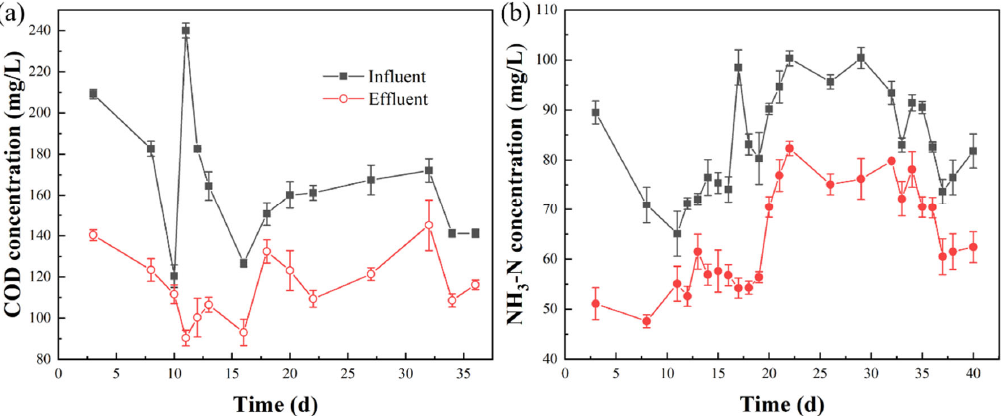
Figure 3. Profiles of COD ( a ) and NH 3 –N ( b ) during the long–term bio–oxidation process.